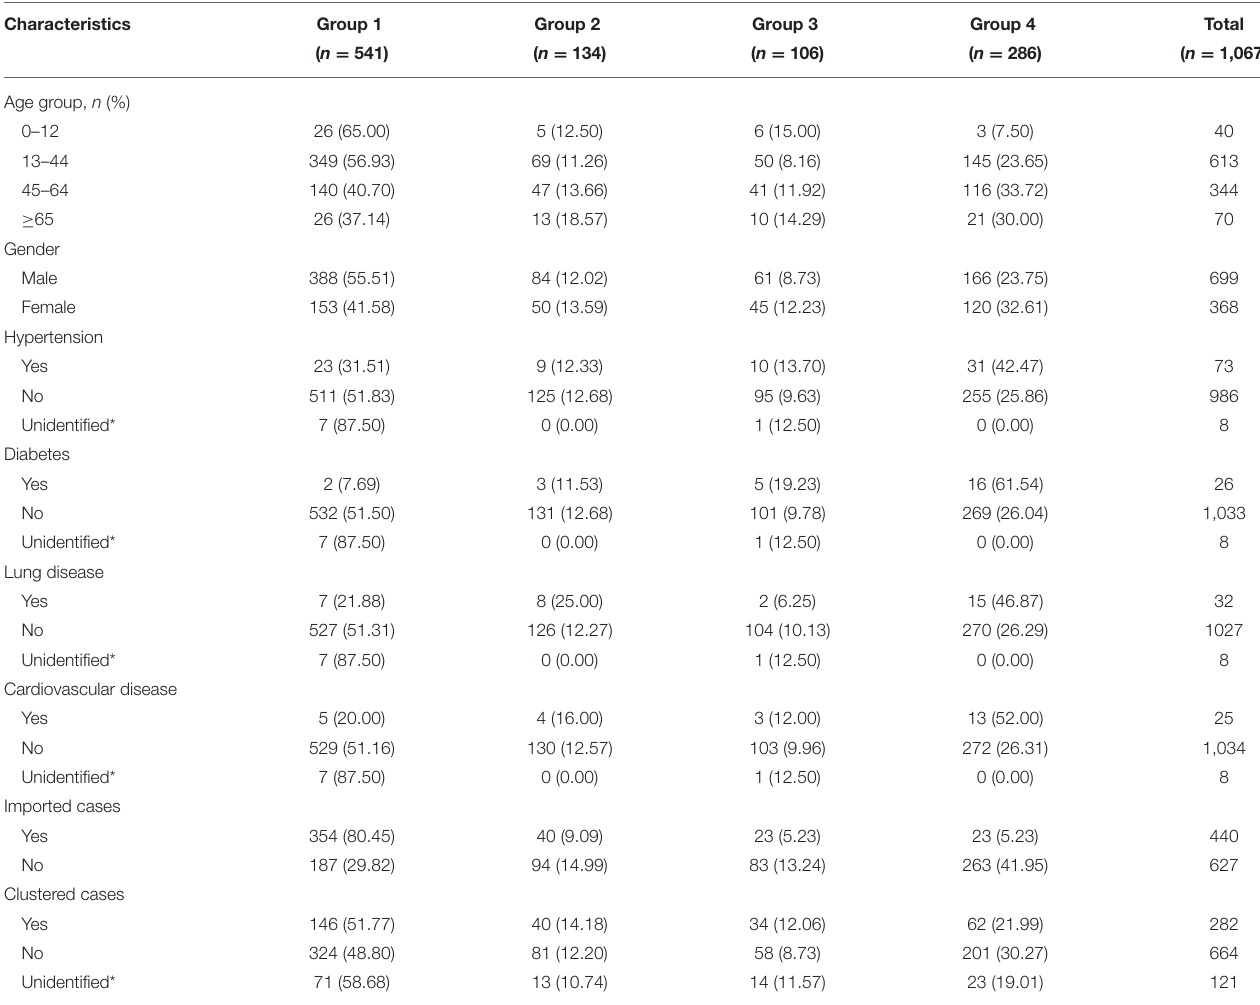
TABLE 1 | Characteristics of cases in different symptoms